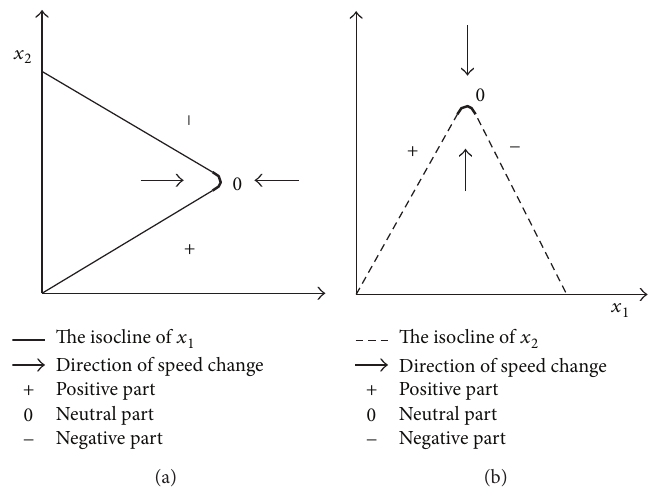
Figure 2: The parabolic zero growth isoclines of message 1 (a) and message 2